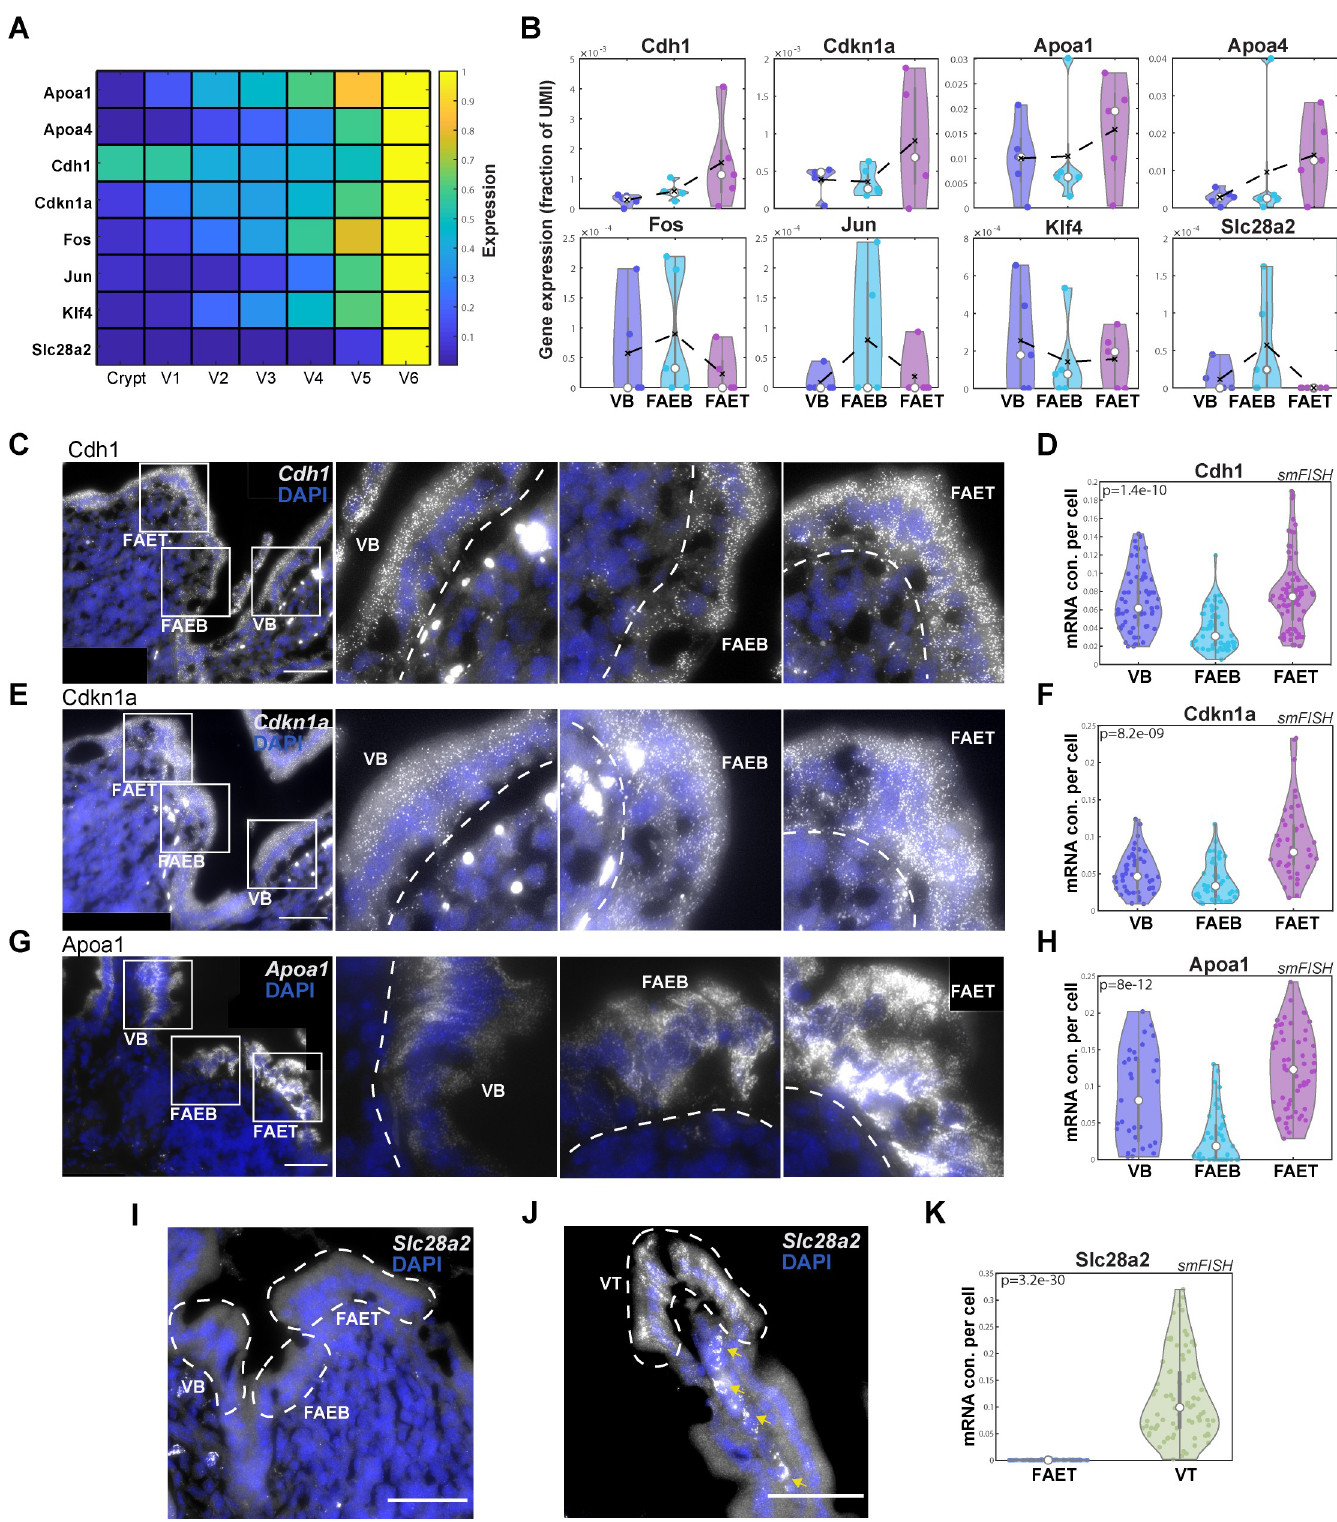
Fig 3. FAET enterocytes exhibit a partial VT program. ( A ) Heatmap of epithelial gene expression along the crypt-villus axis (V1-VB and V6-villus top), showing up- regulated expression of tip program genes (data from [11]). ( B ) Violin plots of gene expression (fraction of UMIs) showing increased expression of Cdh1 , Cdkn1a ,